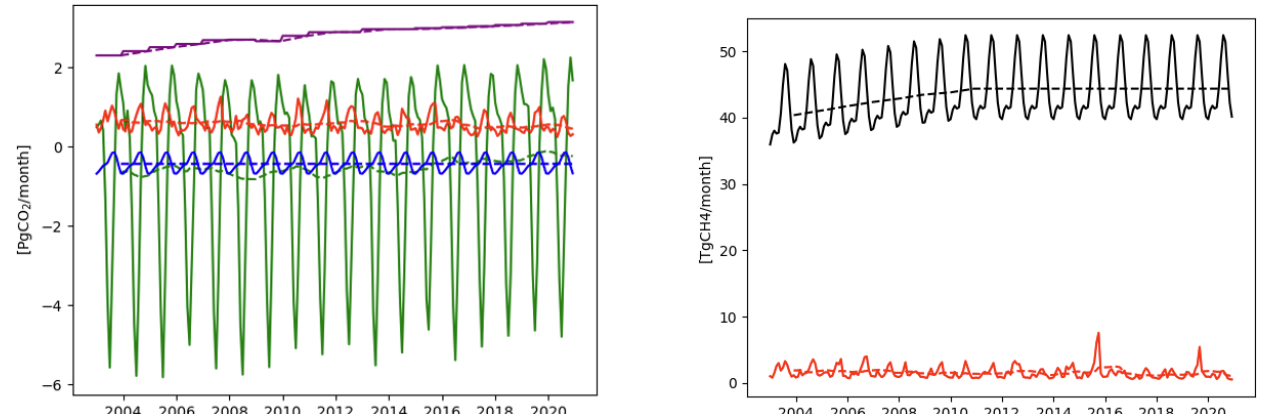
Figure 3. Monthly CO 2 and CH 4 surface fluxes. The CO 2 fluxes (PgCO 2 per month) include modelled net ecosystem exchange (NEE) fluxes (in green), anthropogenic emissions (in purple), ocean fluxes (in blue) and biomass burning emissions (in red). The total CH 4 fluxes (TgCH 4 per month) excluding biomass burning emissions are shown by the black line, and CH 4 biomass burning emissions (TgCH 4 per month) are depicted with the red line. The dashed lines show the 1-year running mean for each of the